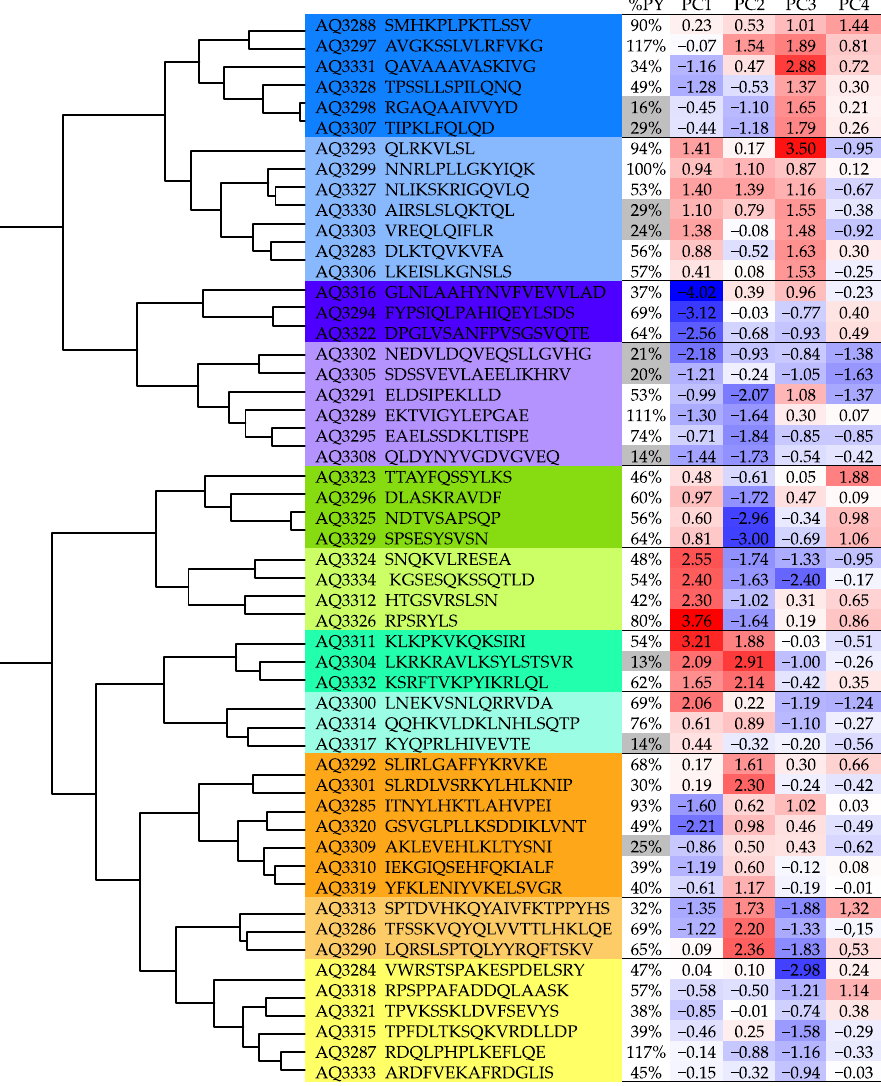
Figure 7. Clustering analysis of the 52 synthesized peptides. Clusters are identified by colors and the principal components are in a scale of red to blue from higher to lower values. Pure yields are indicated in the first column, with the values below 29% highlighted in grey.